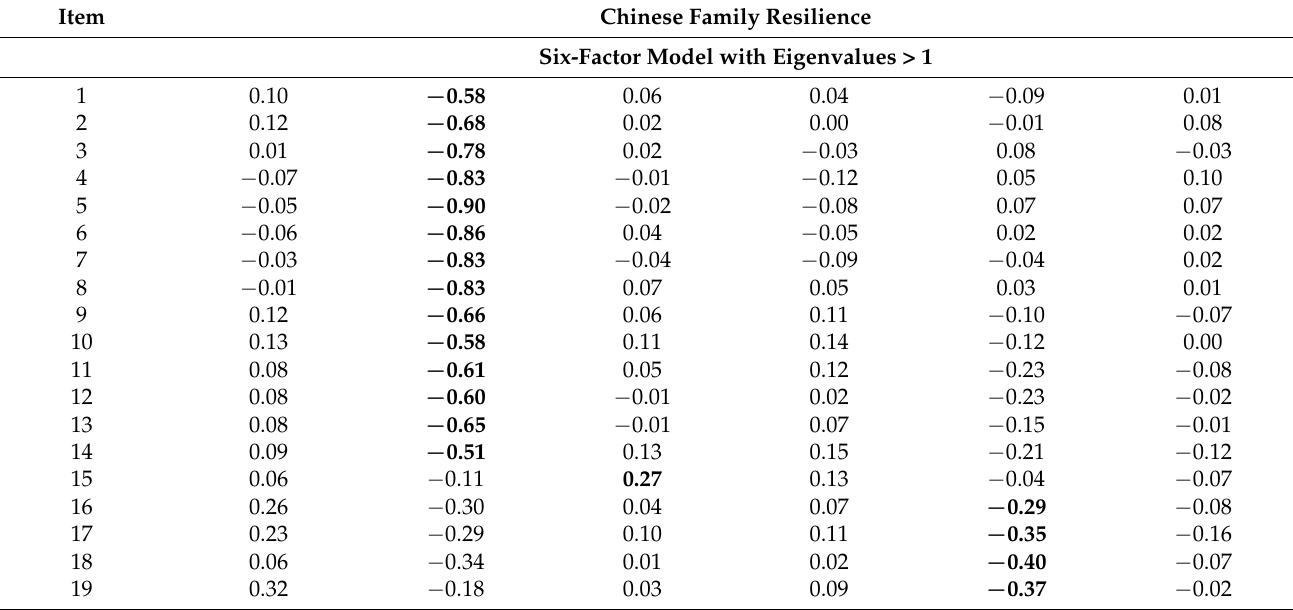
Table 3. Initial Exploratory Factor Analysis (Subsample